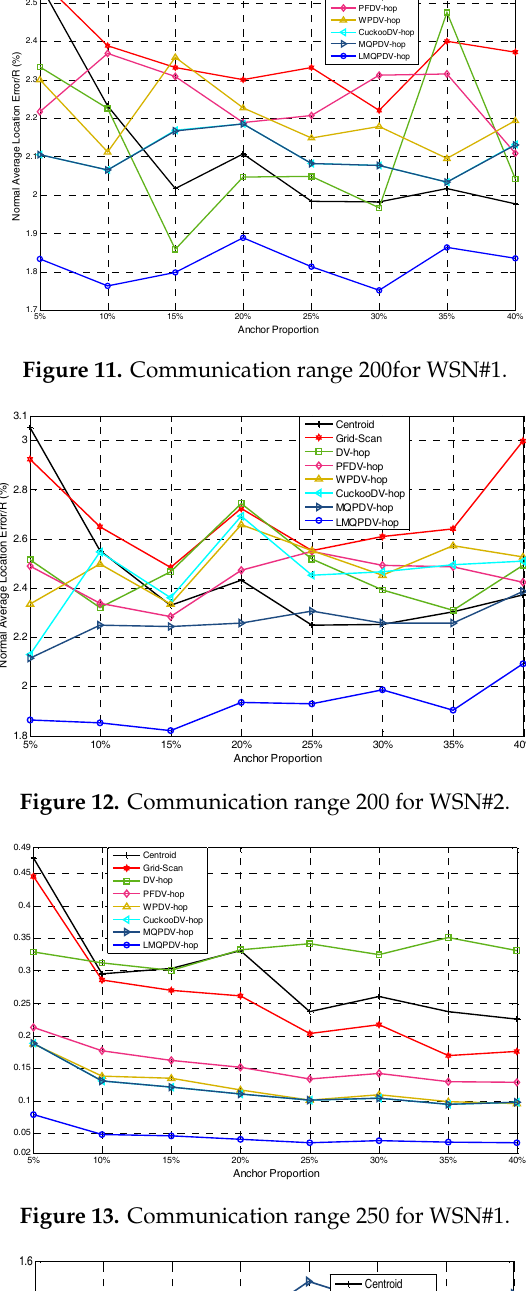
Figure 10. Communication range 150 for WSN#2.